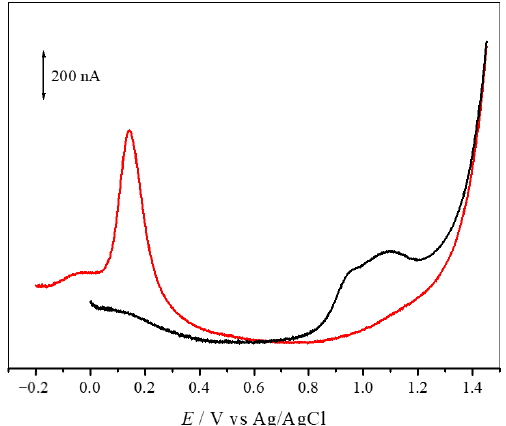
Figure 3. Differential pulse voltammogram for 0.1 mM solutions of ( ▬ ) compound 3 and ( ▬ ) com-